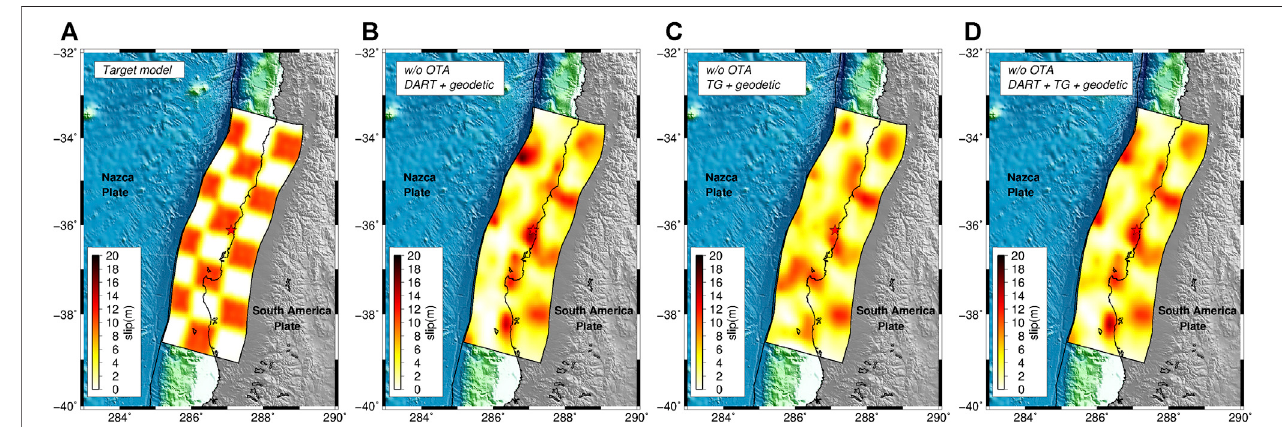
FIGURE 2 | Target slip model (A) ; slip models estimated by jointly inverting geodetic and DART data (B) , geodetic and tide-gauge data (C) , geodetic, DART, and tide-gauge data (D) . All of the inversions have been performed without using OTA.